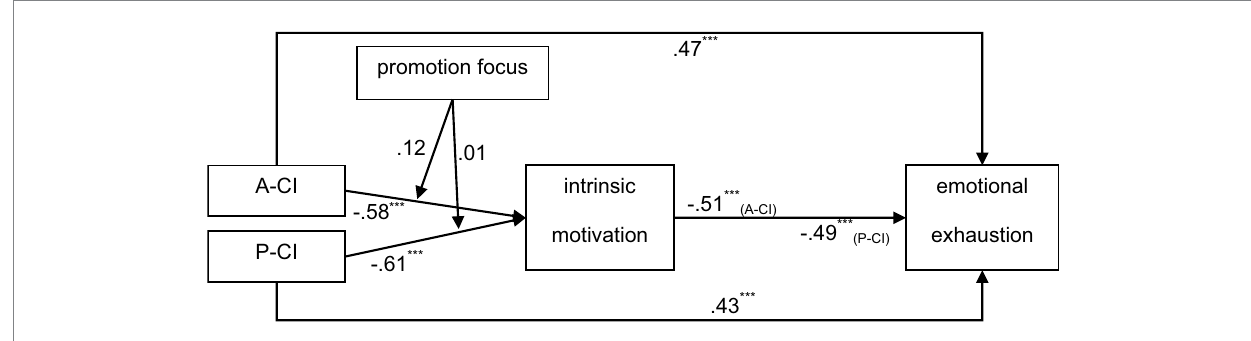
FIGURE 4 Overall results of Study 2. A-CI, Active Cyber Incivility; P-CI, Passive Cyber Incivility. *** p <